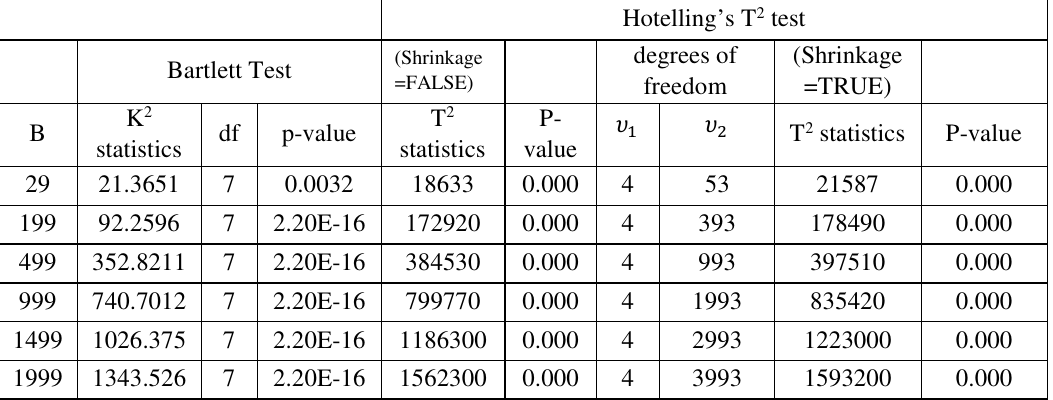
TABLE 3: KUTS PANEL DATA: A SUMMARY TABLE OF BOOTSTRAP SAMPLES (OF SIZE